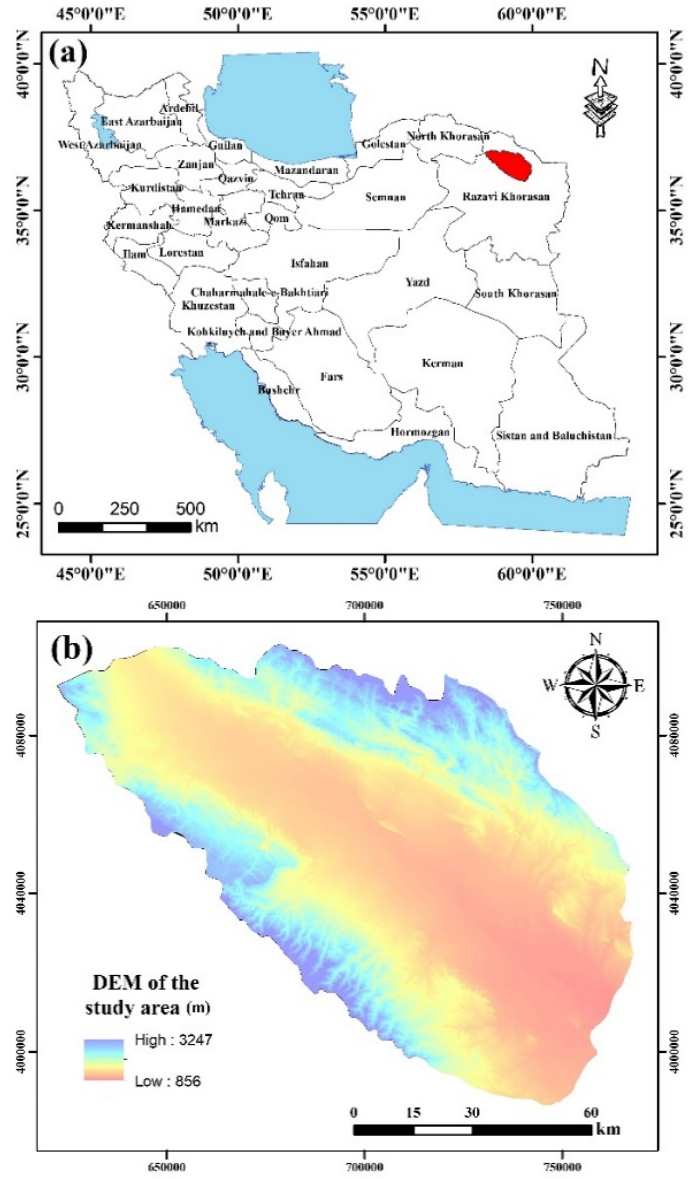
Figure 2. ( a ) The location of the study area in Iran, and ( b ) the DEM of the study region.